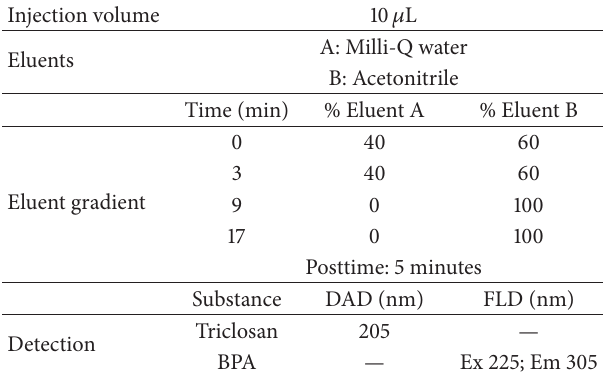
Table 3: High performance liquid chromatography parameters employed in the analysis of bisphenol A (BPA) and triclosan.